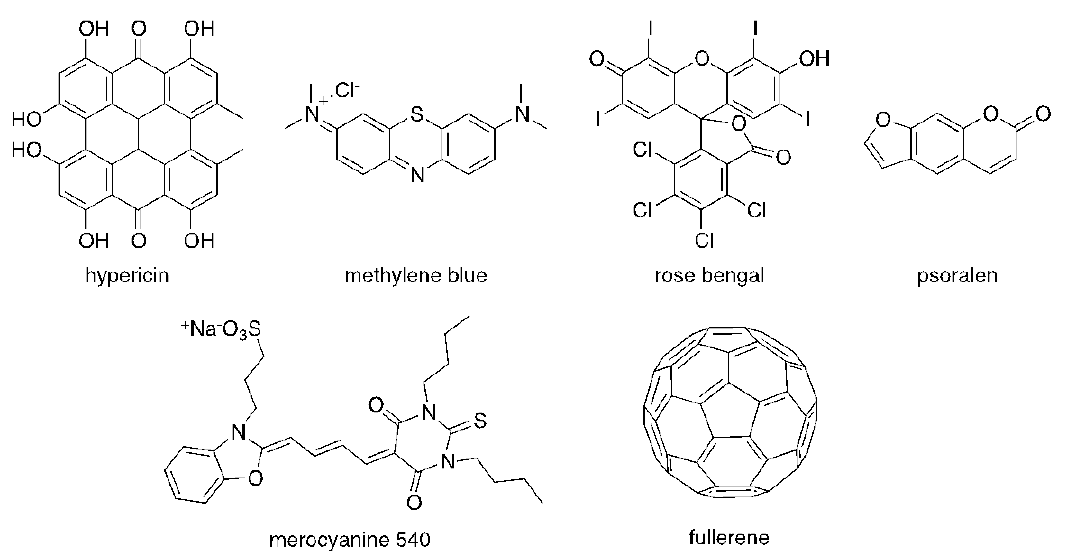
Figure 3. Structure of some non-tetrapyrrolic